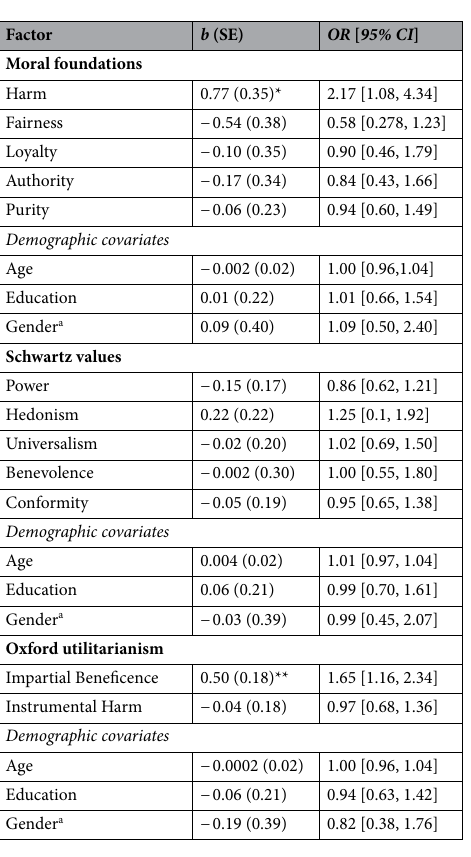
Table 1. Results from Multiple Logistic Regression Models Predicting Altruist Status from (1) Moral Foundations, (2) Schwartz Values, and (3) Oxford Utilitarianism, all Controlling for Sociodemographic Variables. Altruists were coded as ‘1’ and controls were coded as ‘0’. a 0 = female; 1 = male. + P < .1; * P < .05; ** P < .01; *** P <